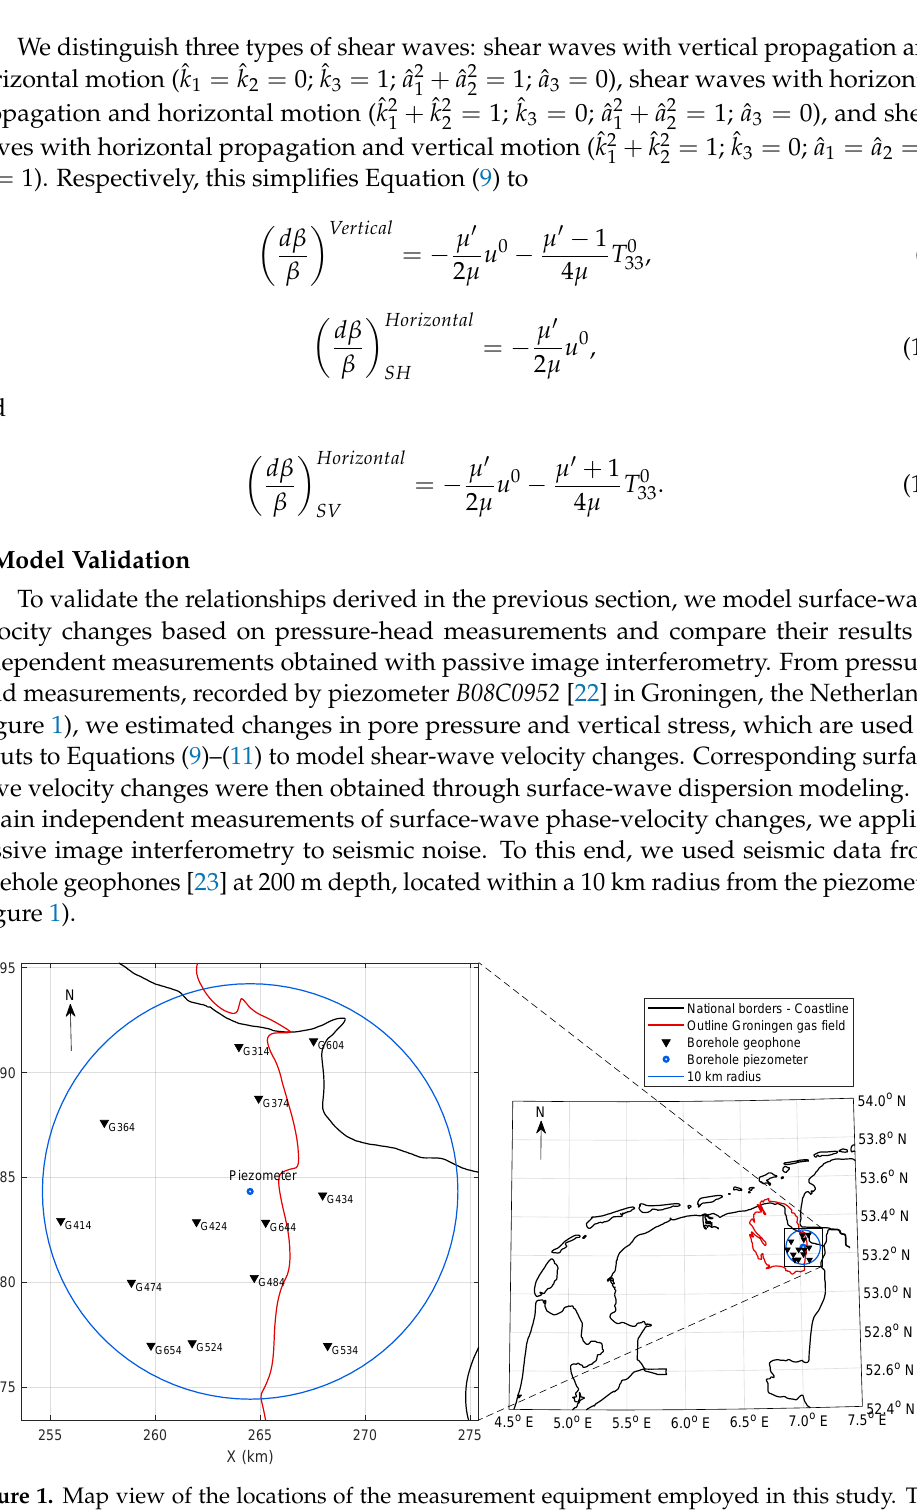
Figure 1. Map view of the locations of the measurement equipment employed in this study. The location of the piezometer B08C0952 [22] is plotted as a blue point, around which the blue circle indicates a 10 km radius. All geophones within this radius at 200 m depth [23] are shown as black triangles. The outline of the Netherlands and the Groningen gas field are shown as black and red